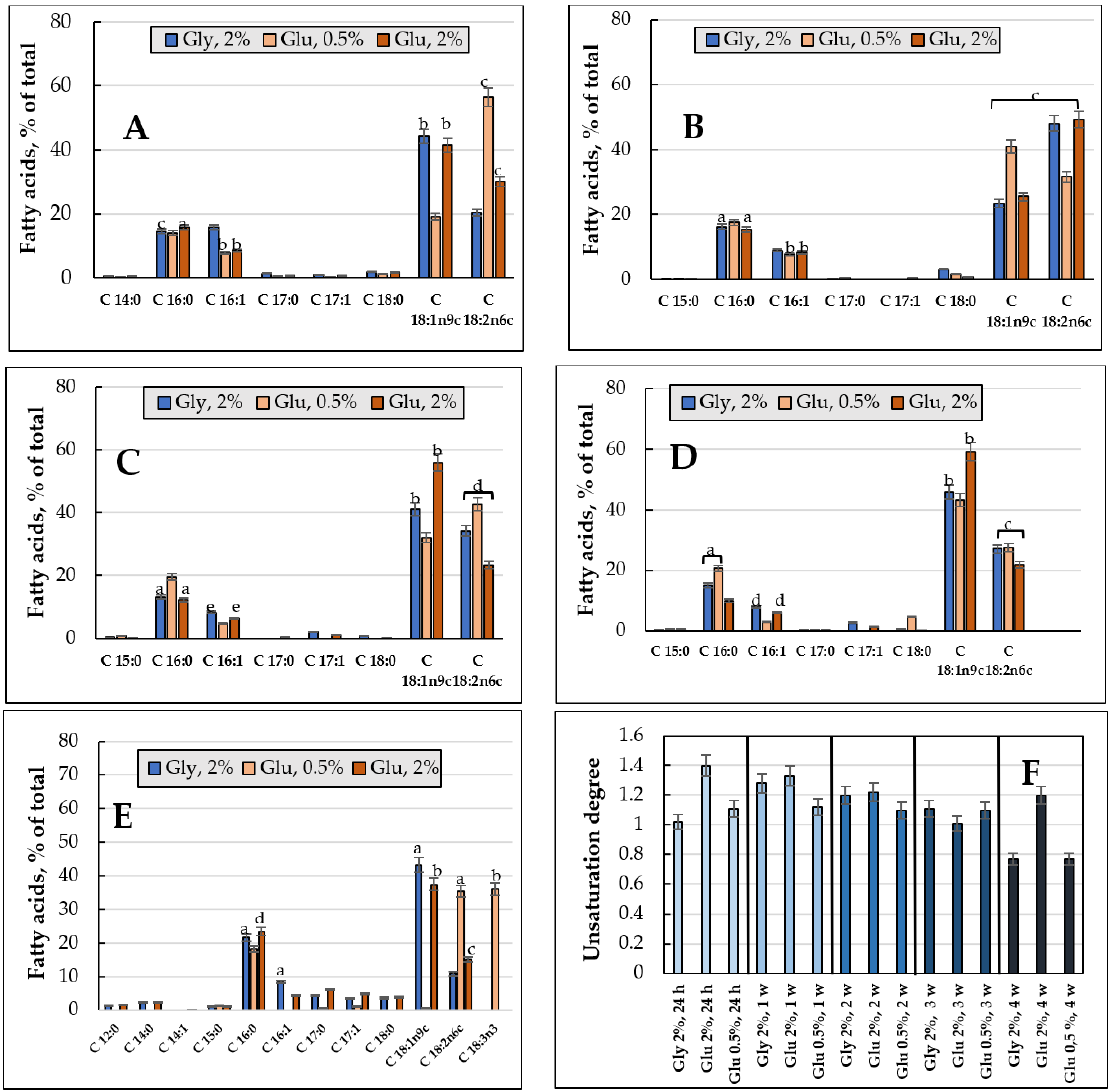
Figure 6. Fatty acid composition of the main membrane phospholipids of E.magnusii (% of total amount). ( A ) 24 h of cultivation; ( B ) 1 week; ( C ) 2 weeks; ( D ) 3 weeks; ( E ) 4 weeks; ( F ) the unsaturation degree. Mean values are displayed (n = 3, ±SD); a— p < 0.04; b— p < 0.01; c— p < 0.001; d— p < 0.02; e— p < 0.02. The means without letters did not differ